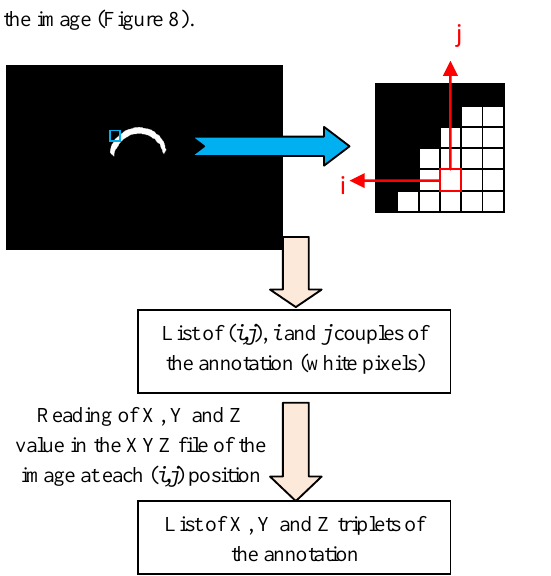
Figure 8: Research of X, Y and Z coordinates of the annotation The annotated area is so defined in space by this list of X, Y and Z triplets (Figure 9).